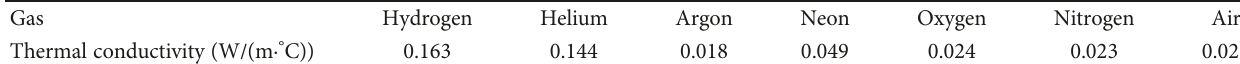
Table 1: Thermal conductivity of several common gases.